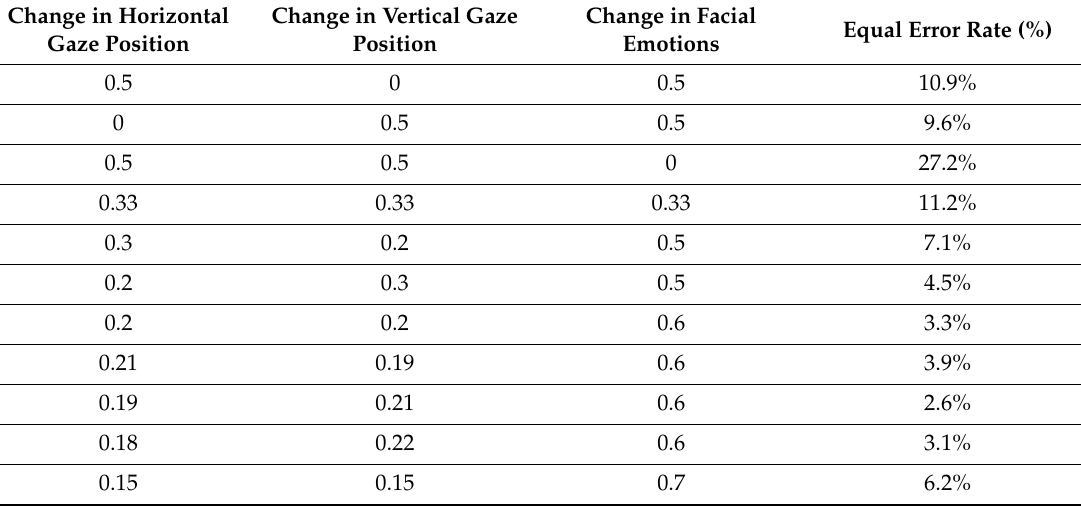
optimal weights based on weighted PRODUCT rule are shown in